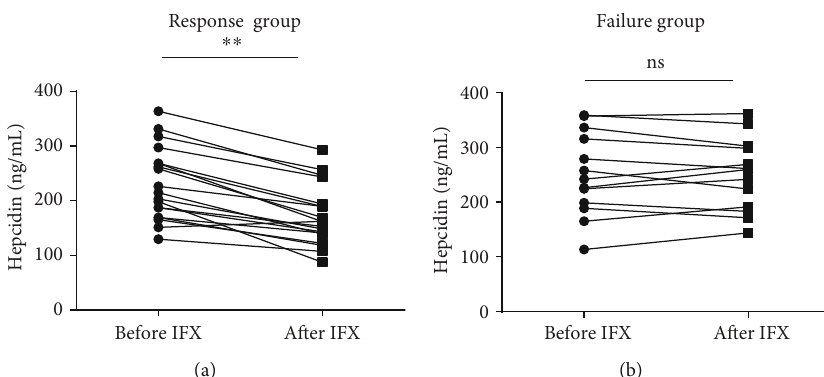
Figure 4: Anti-TNF- α mAb therapy downregulates hepcidin expression in CD patients. 32 patients with A-CD were treated with anti-TNF- α mAb (in fl iximab, IFX) at weeks 0, 2, and 6. Serum samples were collected from these patients prior to and 12 weeks after the fi rst anti-TNF- α mAb therapy; the levels of hepcidin in the Response group ((a), n = 19 ) and the Failure group ((b), n = 13 ) were analyzed by an ELISA. ∗∗ P < 0 : 01 . Unpaired Student ’ s t -tests were performed for statistical